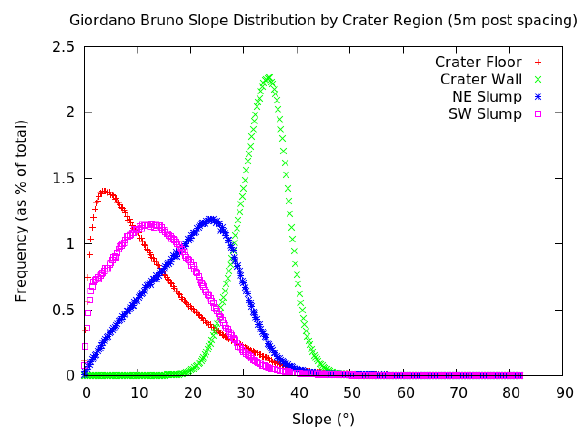
Figure 6. Distribution of slopes over various regions in Giordano Bruno crater, binned at 0.25°. Frequency is given as a percent of total counts for each region.